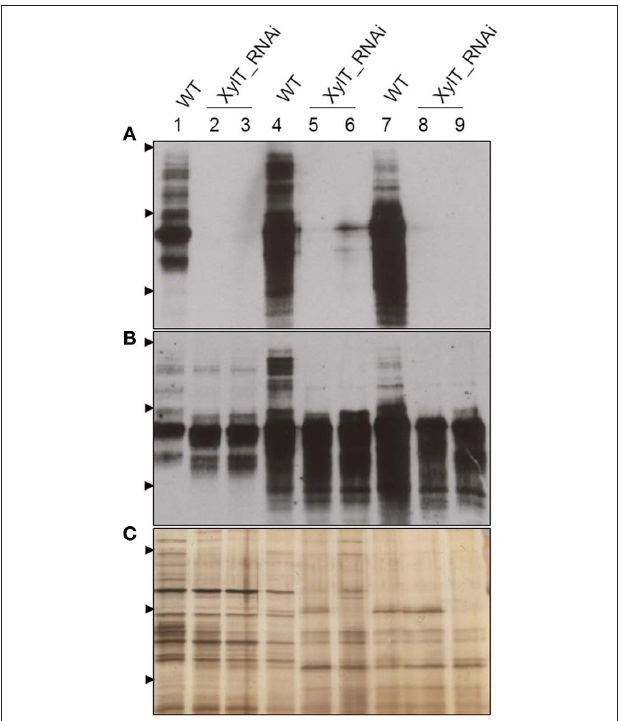
FiguRe 4 | Detection of fucose-containing N- glycans in protein extracts from transgenic XylT_RNAi and wild type tomato fruits. (A) Immunoblot using anti-xylose IgG antibodies; (B) Immunoblots using anti-fucose IgG antibodies; (C) Silver staining of SDS-PAGE. Protein extracts from green (lanes 1–3), orange (lanes 4–6), and red (lanes 7–9) tomato fruits were separated by SDS-PAGE and probed for xylose- or fucose-containing epitopes. Lanes 1, 4, and 7, protein extracts from wild type controls; lanes 2, 5, and 8, protein extracts from the T2 generation of line XylT_RNAi 3–16–10; lanes 3, 6, and 9, protein extracts from the T2 generation of line XylT_RNAi 12–15–1. Arrow heads indicate protein standards of 95, 55, and 36 kDa, respectively.